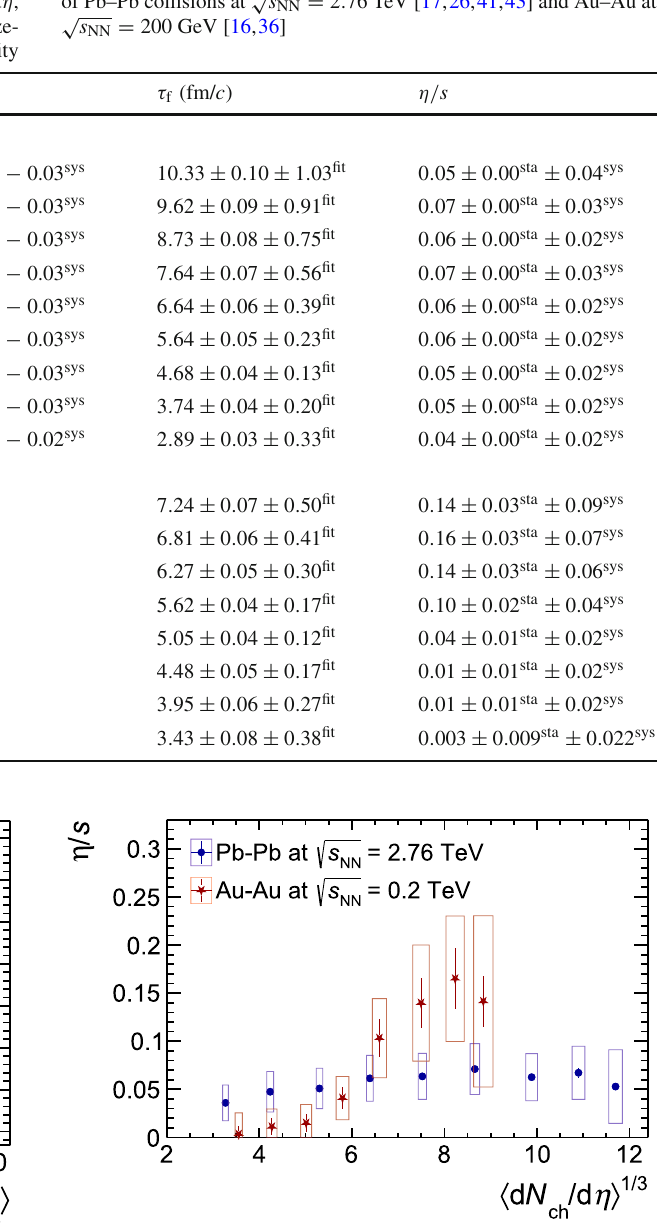
√ s NN = 2 . 76 TeV [17,26,41,43] and Au–Au at √ of Pb–Pb collisions at